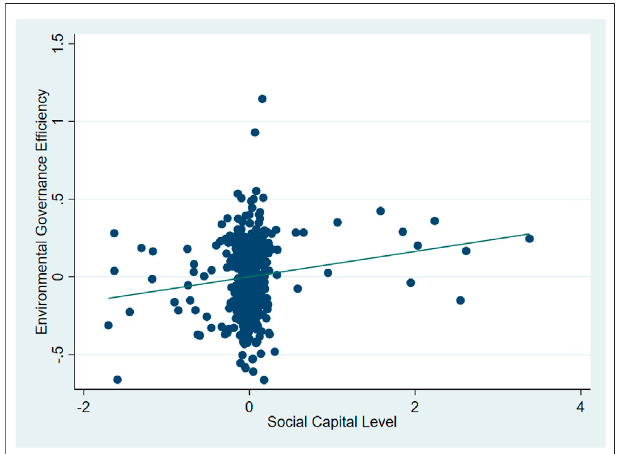
FIGURE 1 | Partial correlation graph between the core variable and the explained